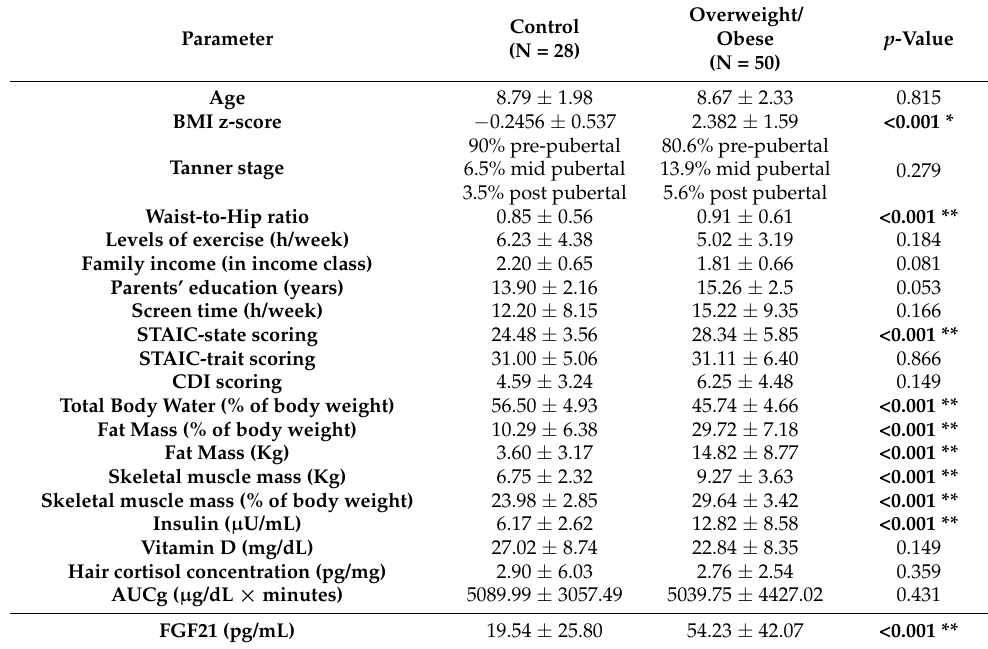
Table 1. Participants’ sociodemographic (age, sex), anthropometric (BMI z-score, Tanner pubertal stage), psychometric, body composition and bioimpedance variables, and their statistical significance between groups (C vs.